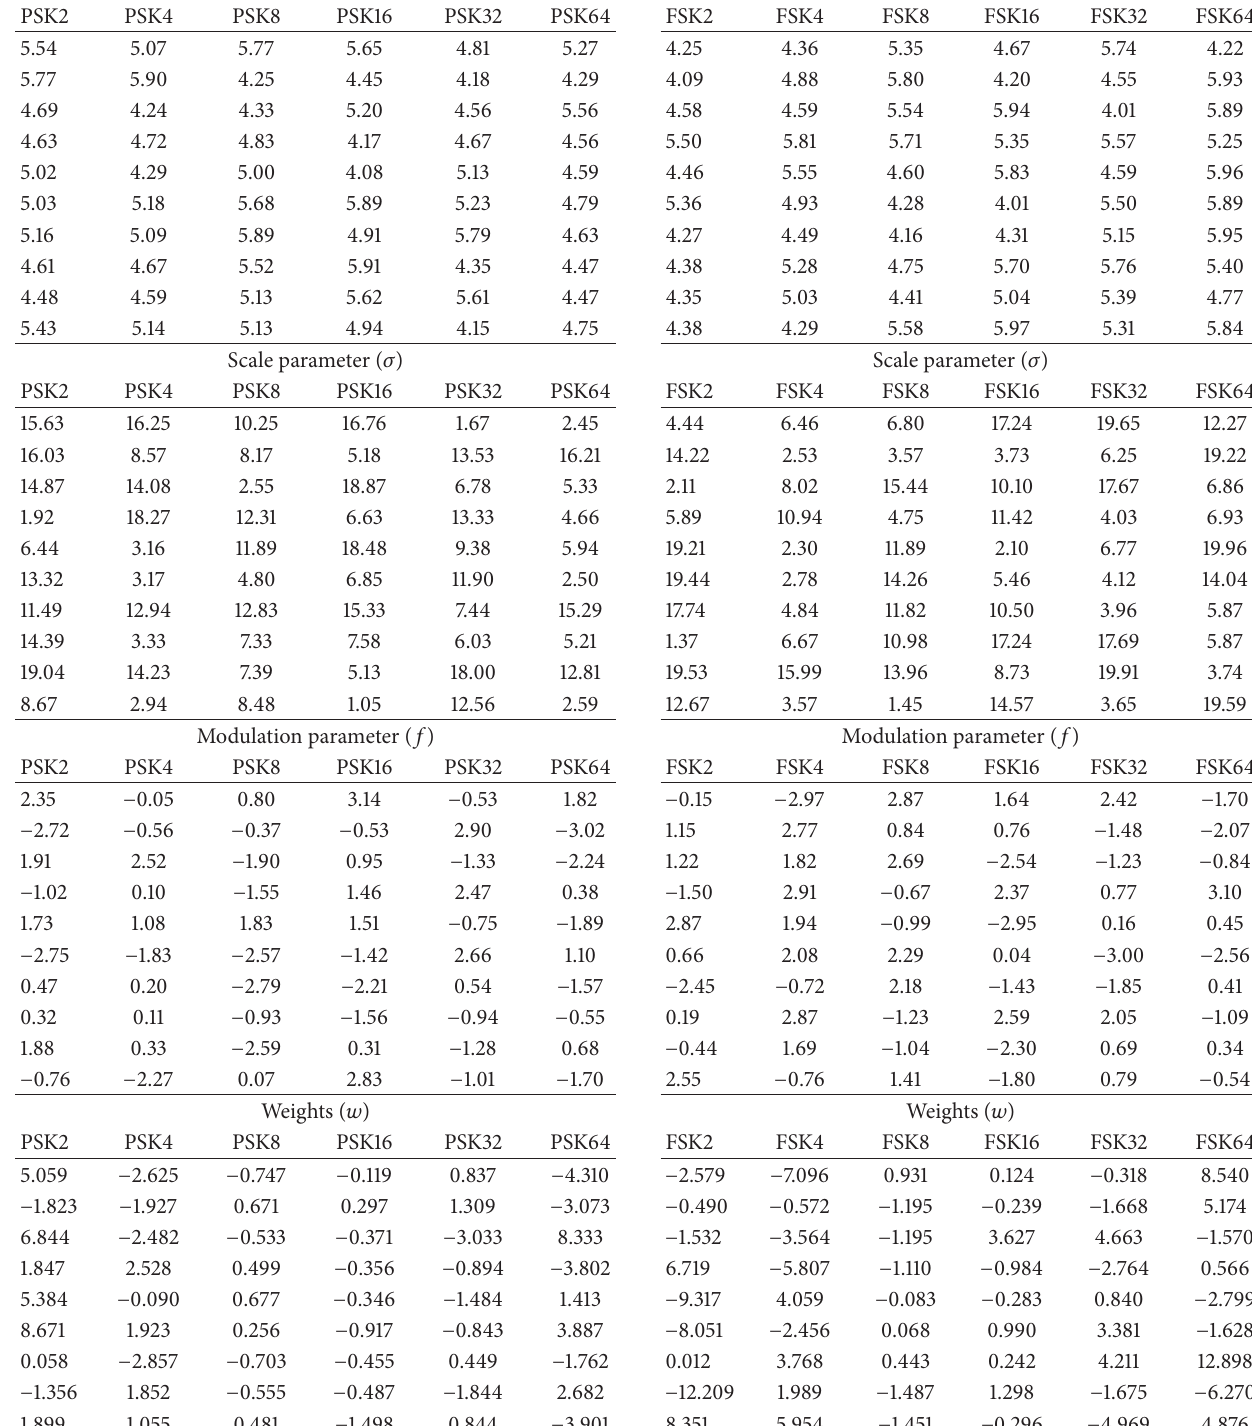
Table 1: Updated Gabor filter atom parameters and weights for PSK modulation 2–64.